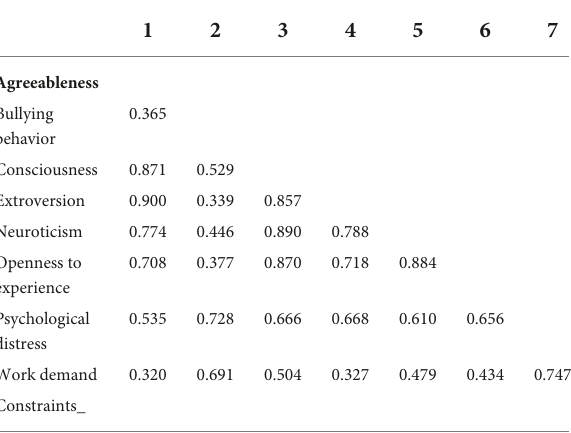
TABLE 4 Heterotrait-monotrait (HTMT)